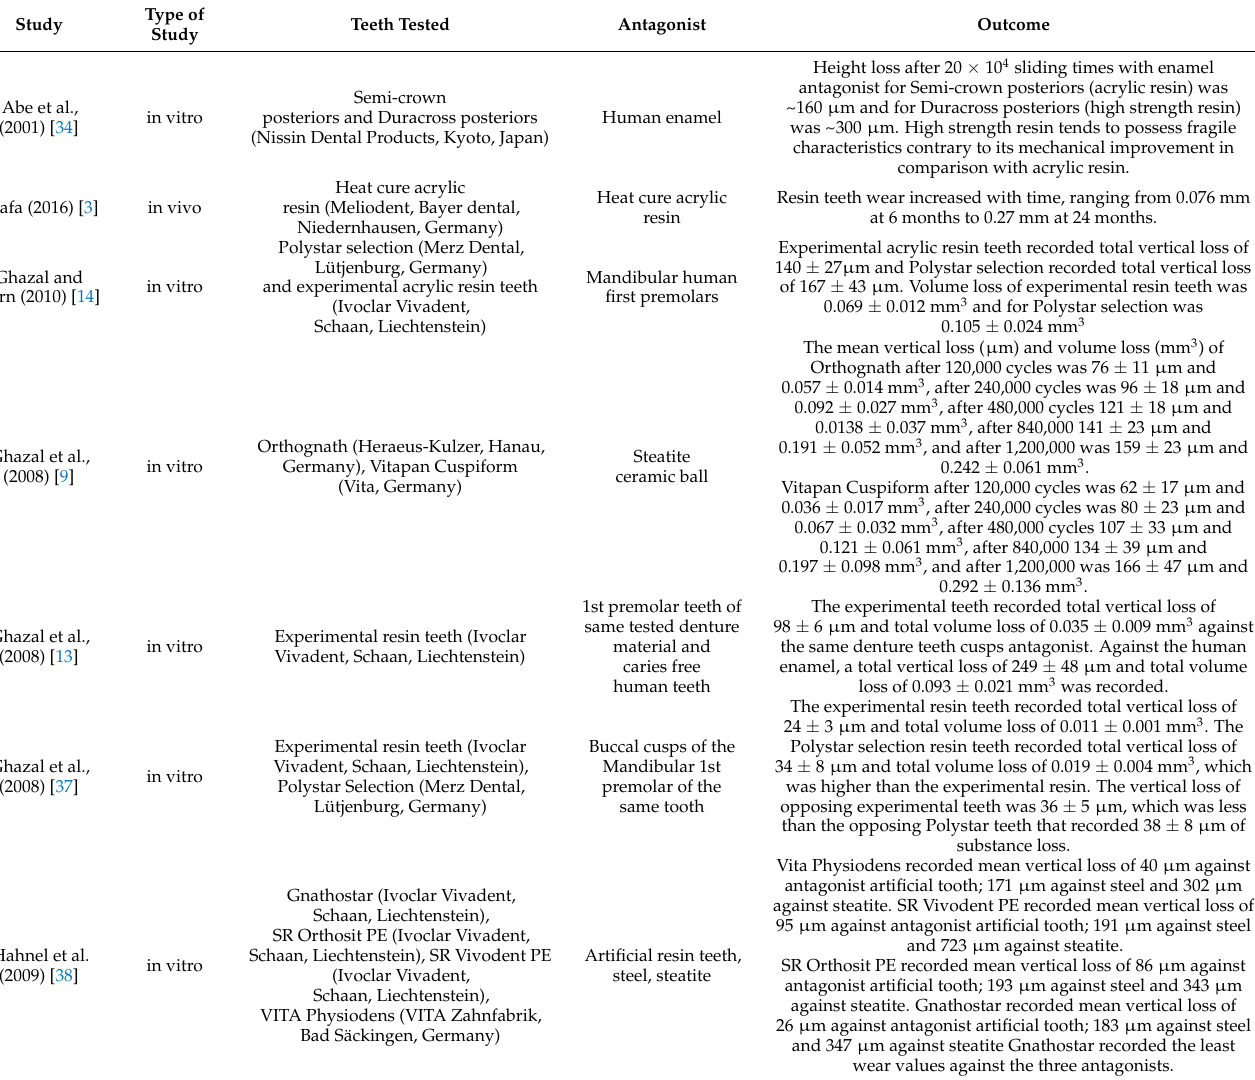
Table 3. Main findings of the selected studies on denture teeth wear (PMMA).